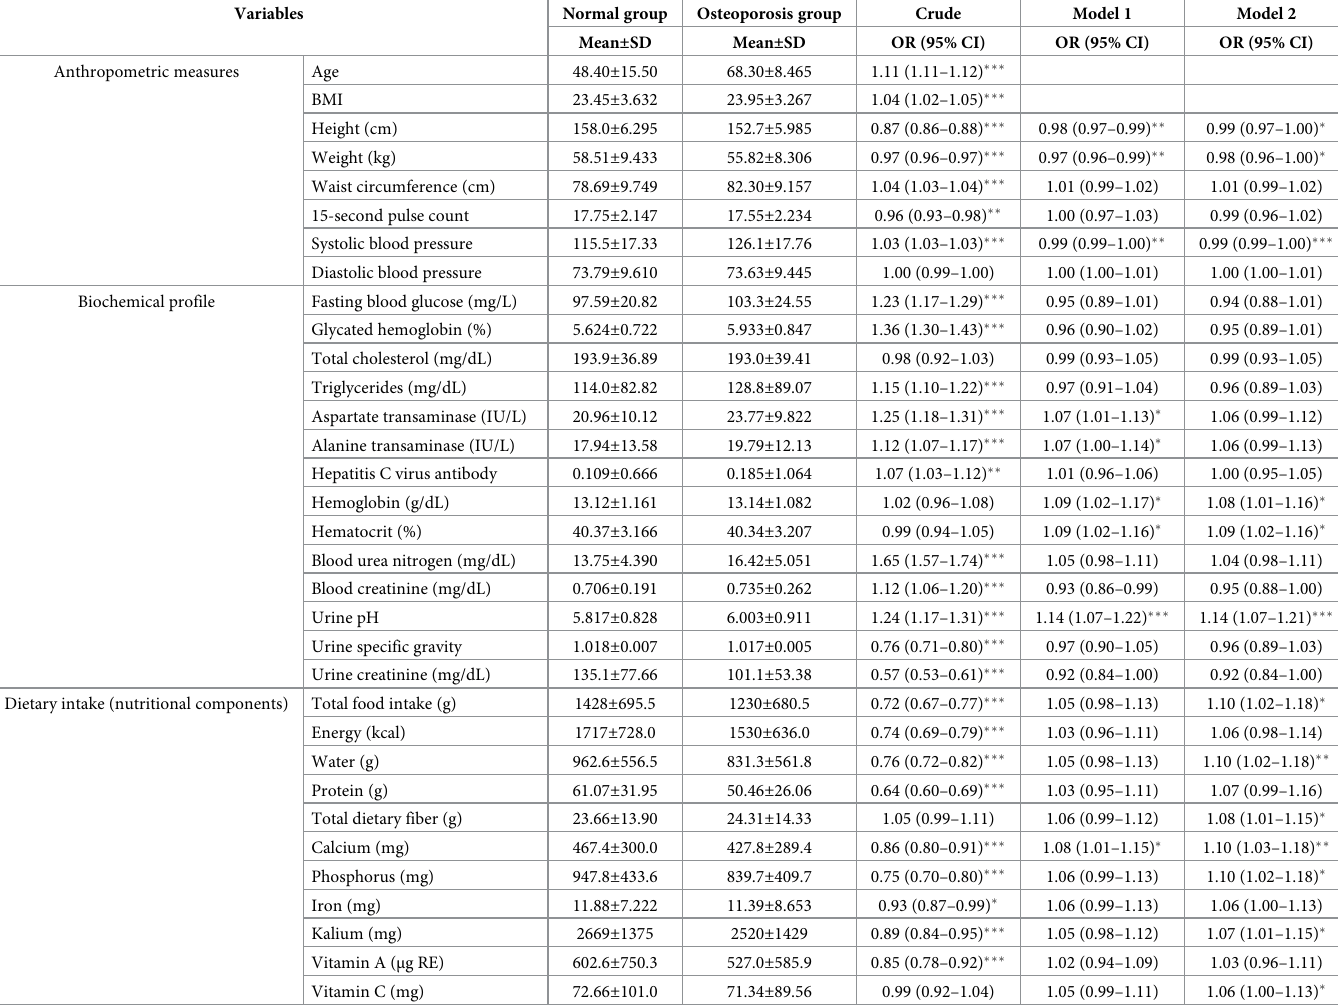
Table 4. Association of osteoporosis with anthropometric measures, the biochemical profile, and dietary intake in women.